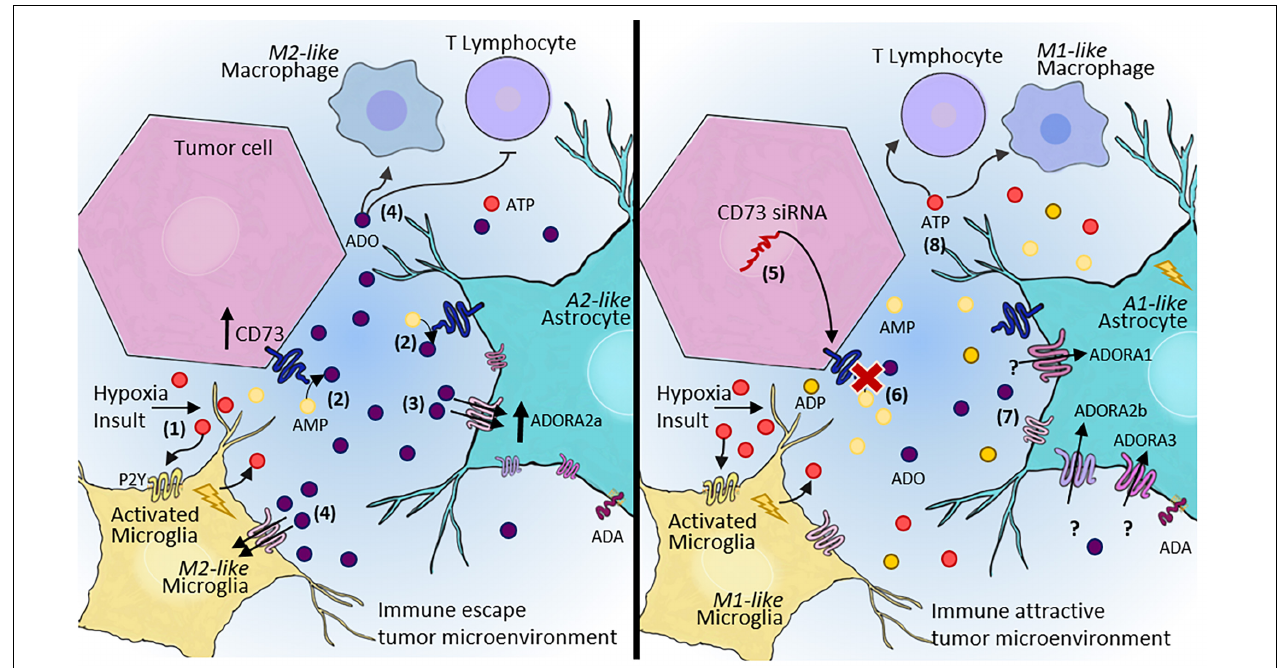
FIGURE 3 | Adenosinergic signaling as a therapeutic target for GB treatment. (1) After hypoxia or other insults, microglia and astrocytes become reactive, contributing to the release of ATP into the extracellular space. (2) Our hypothesis is that rapid conversion of ATP to ADO via CD73 activity expressed by both tumor cells and A2 -astrocytes in the TME promote immune escape. (3) ADO can sensitize P1 receptors, mainly A 2A R, contributing to the maintenance of escape from immune surveillance, and consequently, increasing tumor malignancy and progression. (4) ADO promotes an immunosuppressive TME, which inhibits T lymphocyte recruitment and induces M2-like macrophage/microglia polarization. (5) In contrast, a therapeutic approach blocking CD73 may alter this entire pathway, (6) leading to decreased extracellular ADO. (7) A decreased ADO concentration in the TME may contribute to A1-astrocyte polarization and consequent impairment of tumor growth. A1 -astrocytes overexpress A 1 R, A 2B R, and A 3 R, but this effect has not been elucidated in tumors. (8) In summary, a therapeutic approach aimed at blocking adenosinergic signaling would establish an immune-attractive tumor microenvironment, resulting in the recruitment of effective immune cells to combat tumor cells. ATP, adenosine triphosphate; AMP, adenosine monophosphate; ADO, adenosine; siRNA, small interfering RNA; TME, tumor